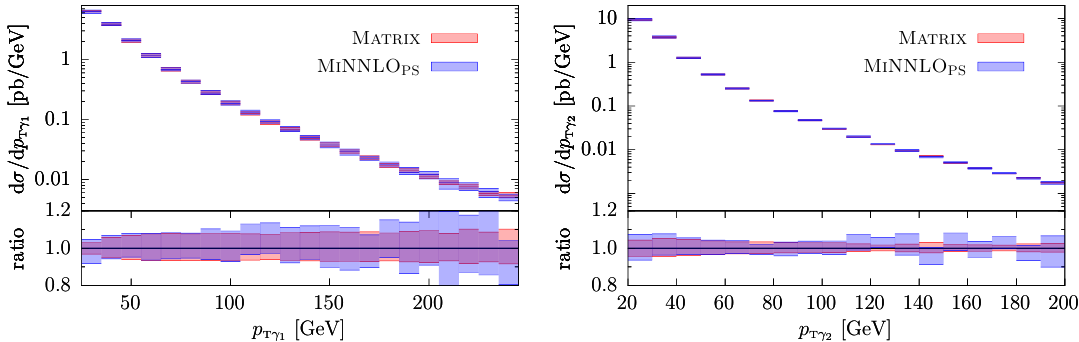
Figure 4 . Comparison between fixed-order results from Matrix and MiNNLO PS for the trans- verse momentum of the hardest and next-to-hardest photon. Uncertainty bands from scale varia- tions are also